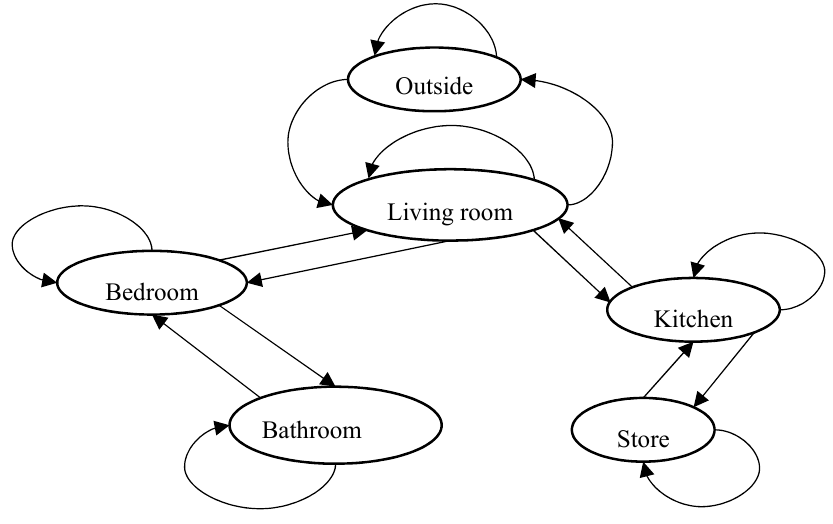
Figure 2. Room-to-room State Transition Model.